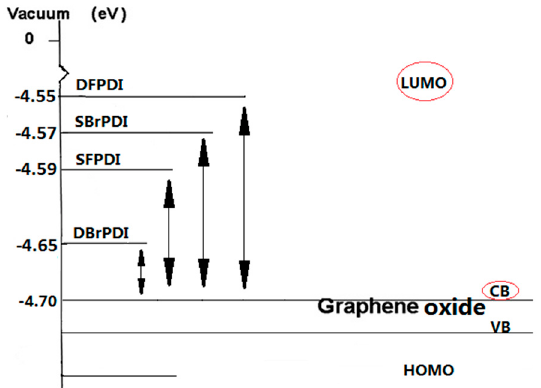
Figure 5. Schematic energy-level diagram of GO relative to the level of the excited-state dyes. CB: conduction band, VB: valence band, HOMO: highest occupied molecular orbital.